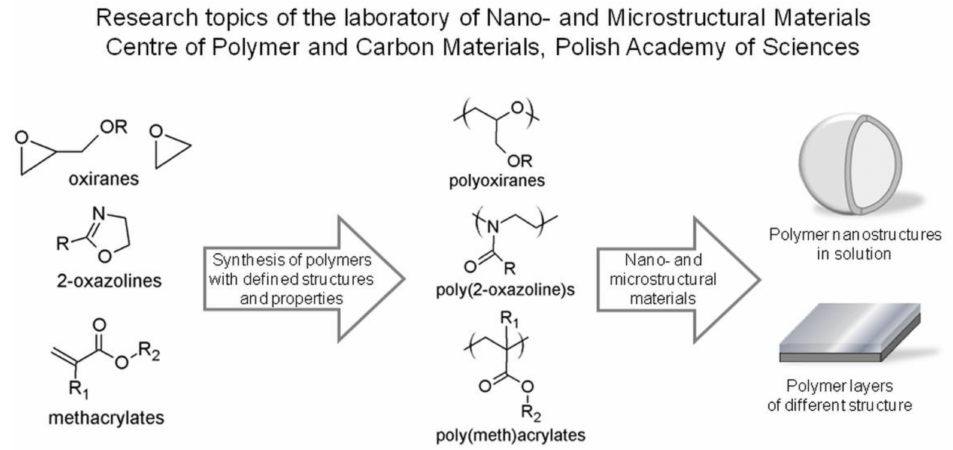
Figure 1. Schematic representation of the monomers, polymers and nano- and microstructural materials obtained in the Laboratory of Nano- and Microstructural Materials of CMPW